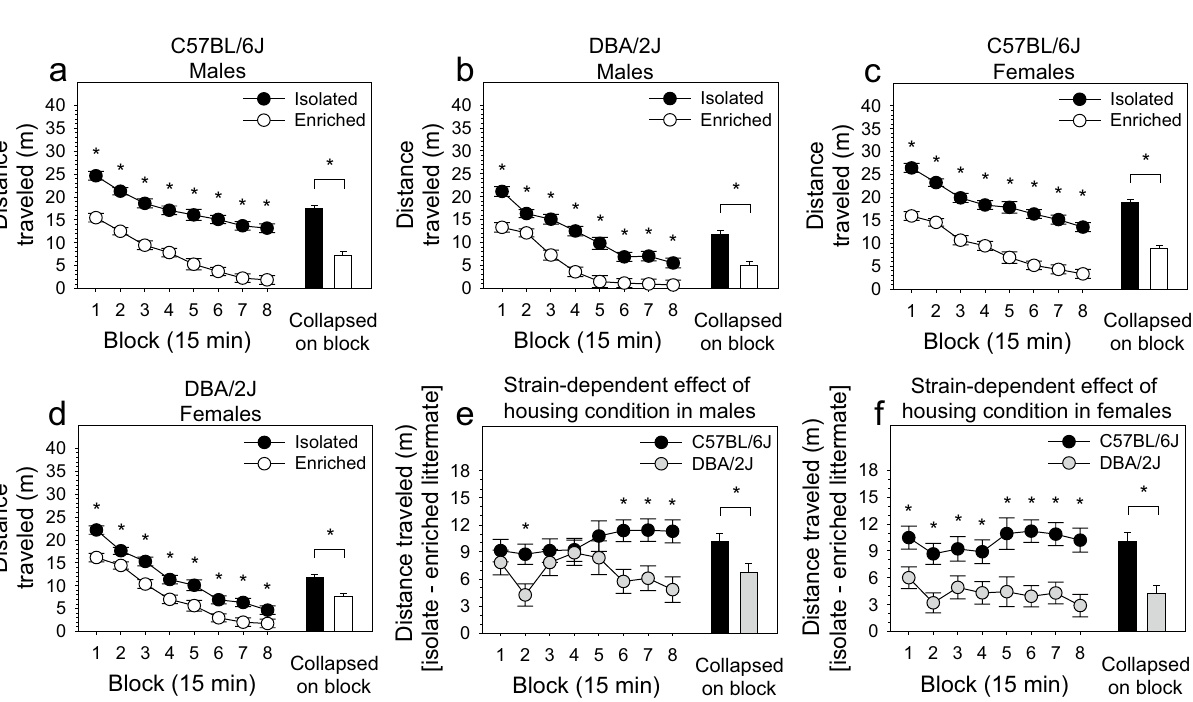
Figure 1. Environmental enrichment reduced novelty reactivity in an open field significantly more in C57BL/6J mice relative to DBA/2J mice. ( a , b , c , d) Environmentally enriched mice explored the open field significantly less than isolated mice; this was true for both C57BL/6J and DBA/2J strains and for males and females within these strains ( p < .05 for all tests). Males explored significantly less than females ( p < .05) irrespective of housing condition and strain. DBA/2J mice explored significantly less than C57BL/6J mice in both the isolation and enrichment housing conditions ( p < .05). ( e , f ) The reduction in novelty reactivity following environmental enrichment was significantly greater ( p < .05) in the C57BL/6J strain than in the DBA/2J strain in both male and female